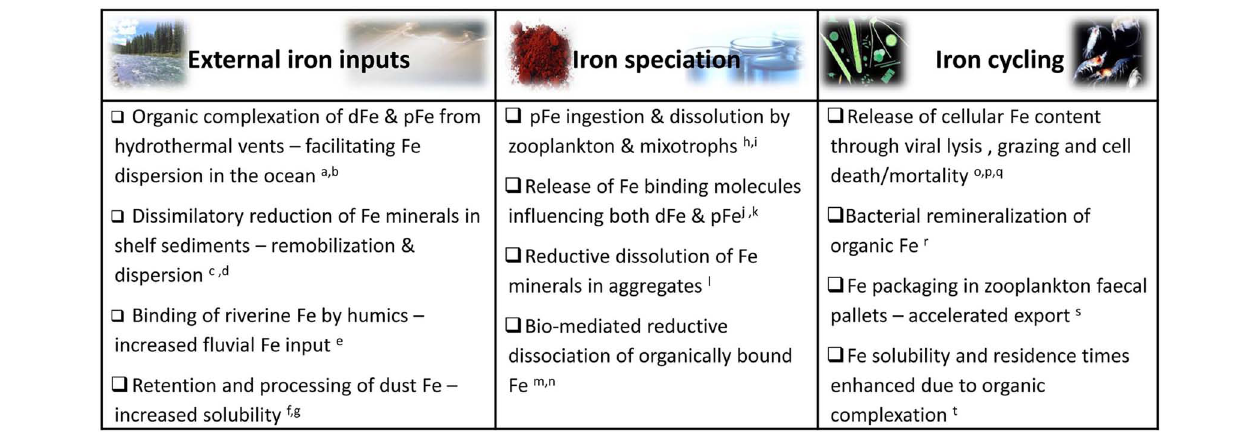
FIGURE 6 | Selected examples of biological interactions with external iron inputs (e.g., aeolian dust deposition, sediment resuspension, fluvial, and hydrothermal Fe) and organism mediated influences on iron speciation and recycling in aquatic environments. While the microbial web in its entirety (from grazers to primary producers, viruses and heterotrophic bacteria) influences iron dynamics and availability to all community members, we focus on resultant Fe bioavailability to photosynthetic microorganisms. Abbreviations: dFe,